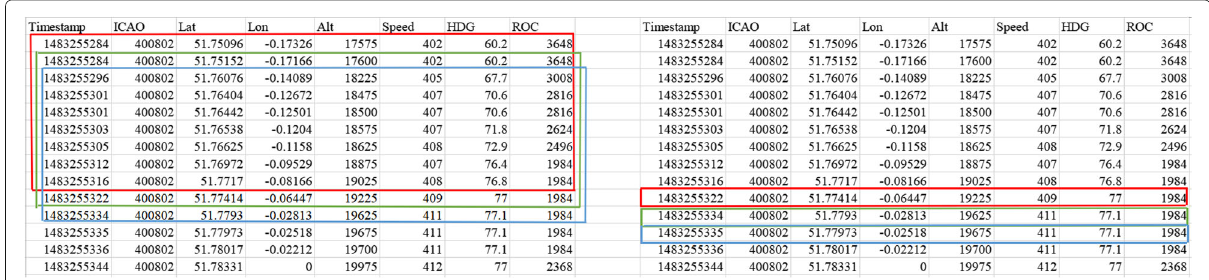
Fig. 5 Illustration of sliding window. First uses the data with the serial number [1,10] to predict the 11th data; then, by sliding the window, the data with the serial number [2,11] are used to predict the 12th data, and the rest of the data all follow this